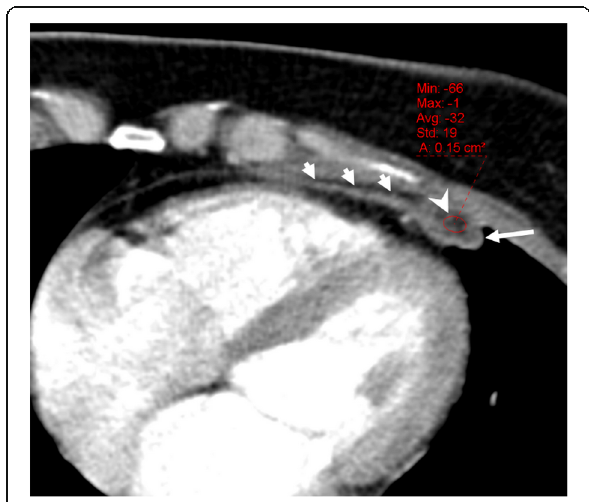
Fig. 24 A 46-year-old woman with a 5-day history of chest pain and shortness of breath. Axial contrast-enhanced CT image demonstrates the fat-containing (arrowhead) soft tissue thickness (long arrow) and associated pericardial thickening (short arrows) compatible with pericardial/epipericardial fat necrosis. The CT findings resolved